Question: What kind of plot is shown here?
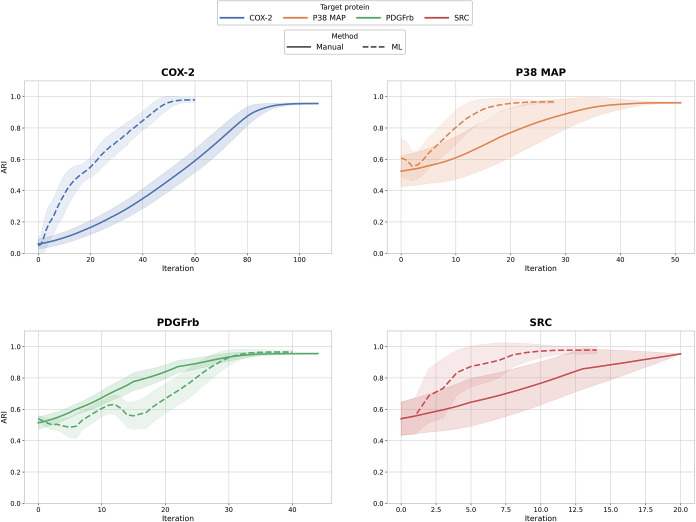
Answer: line